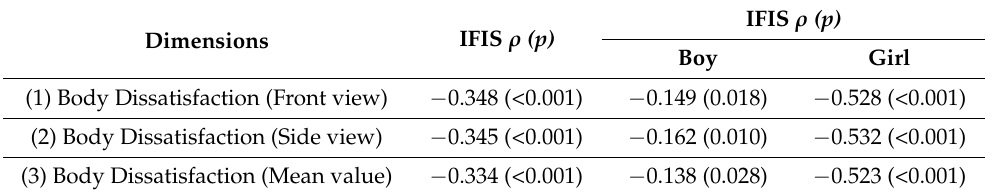
Table 1. Correlation between body dissatisfaction and International Fitness Scale (IFIS).